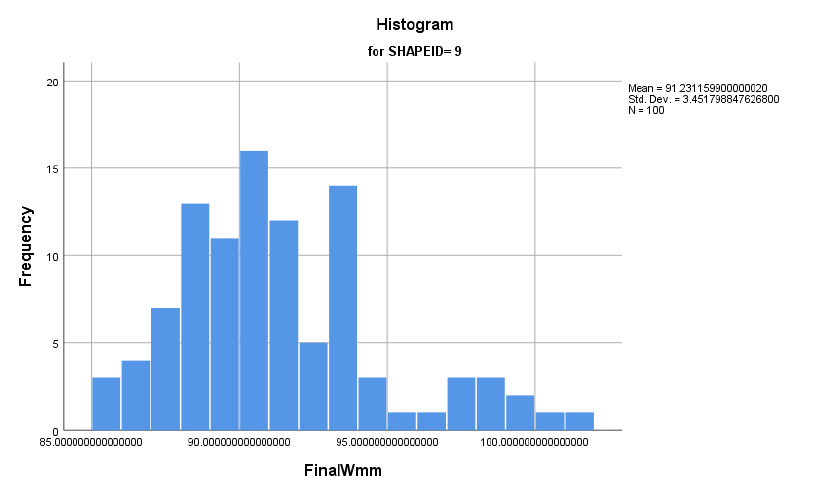
Figure A20. Grow width adjustment for 90